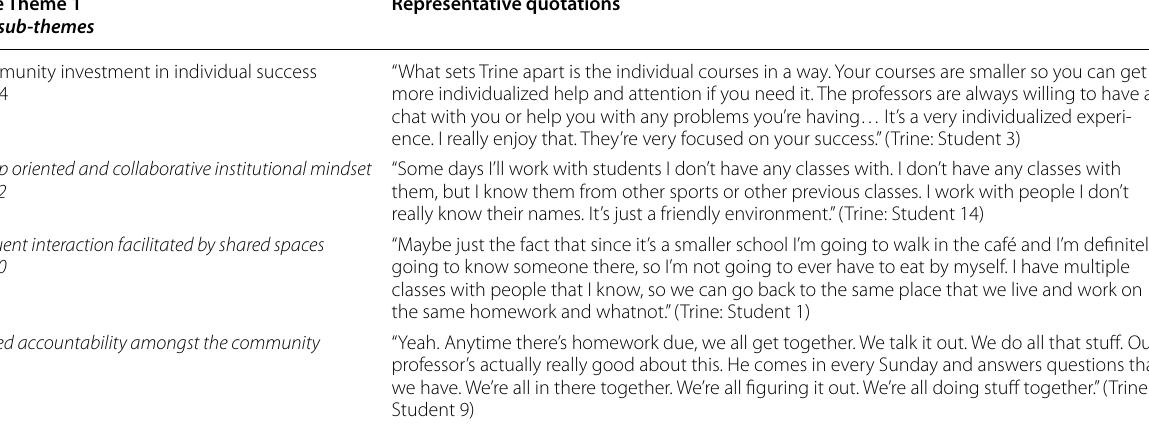
Table 8 Trine institutional analysis—Theme 1 Trine Theme 1 and